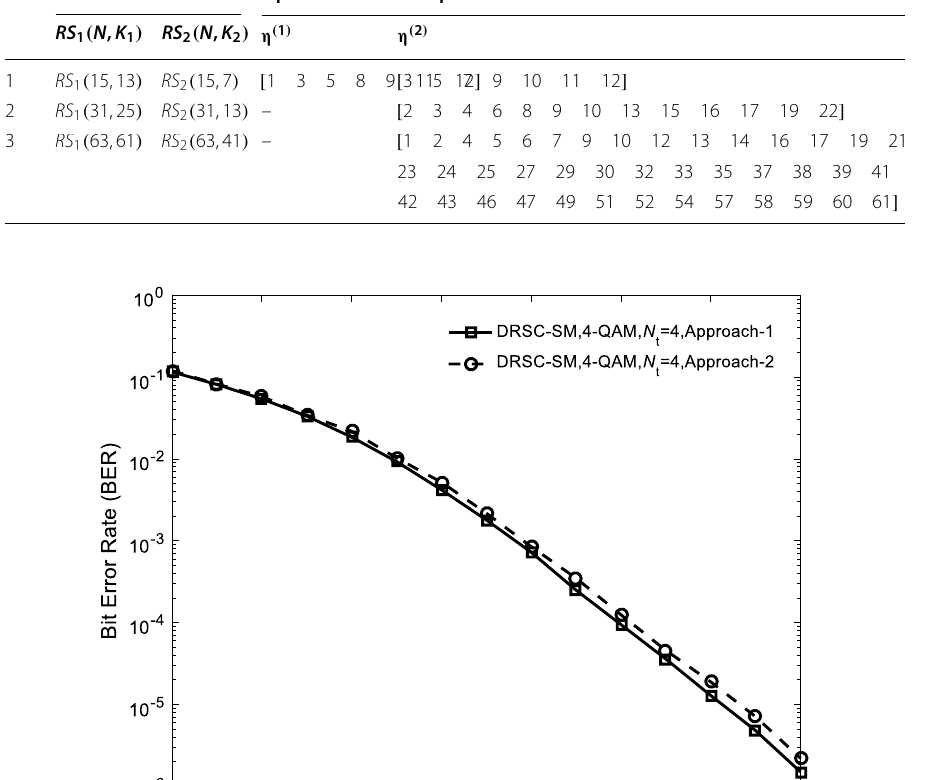
Table 5 Relationship between different distributed RS codes and optimized selection patterns No. Distributed RS codes